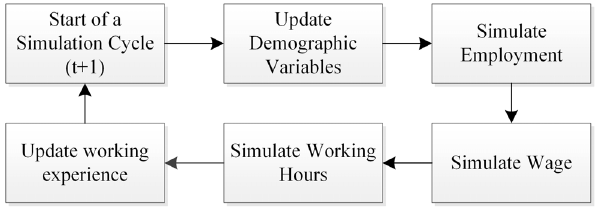
Figure 1. An Overview of Simulation Steps. doi:10.1371/journal.pone.0111903.g001 PLOS ONE |